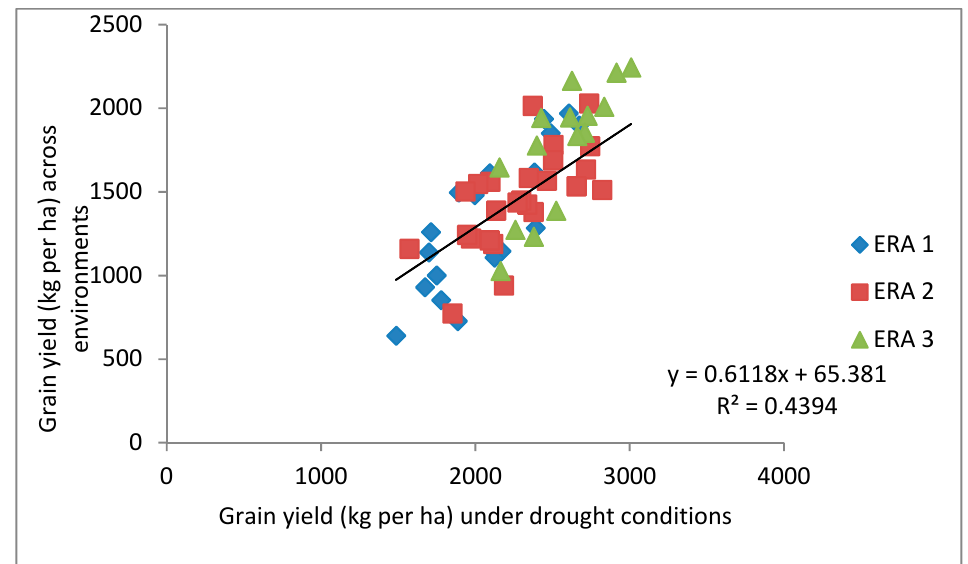
Figure 2. Performance of extra-early maize hybrids of three breeding periods under drought con- ditions versus across research environments.